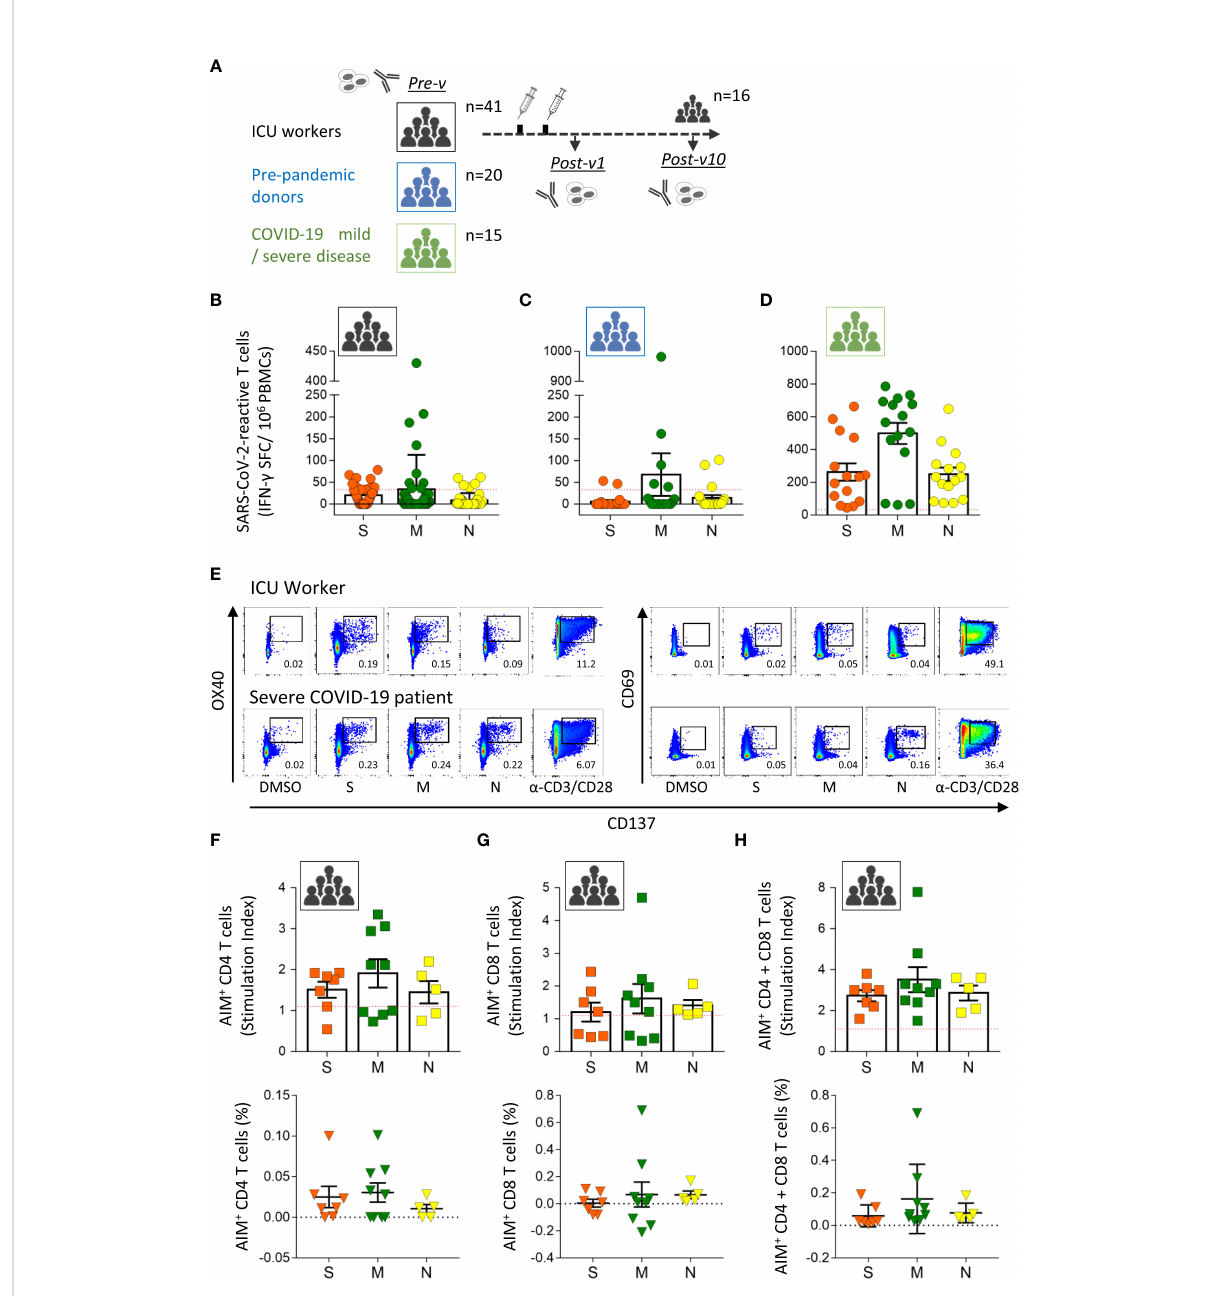
FIGURE 1 Pre-existing SARS-CoV-2-speci fi c T cells in healthy ICU workers. (A) Study design. Blood samples were taken from intensive care unit workers with no known antecedents of COVID-19 before vaccination (n=41, Pre-v), and 1 month (n=41, Post-v1) and 10 months (n=16, Post-v10) after receiving two doses of the mRNA vaccine. Pre-pandemic healthy donors (n=20) and COVID-19 convalescent patients (n=15) with mild and severe disease were used as control groups. Antibody levels and SARS-CoV-2-reactive T cells were assayed at the indicated times. Frequencies of IFN- g -producing T cells assayed by ELISpot assay against spike (S, orange circles), membrane (M, green circles) and nucleocapsid (N, yellow circles) proteins in samples from ICU workers (B) taken before vaccination, pre-pandemic healthy donors (C) and convalescent patients recovered from COVID-19 (D) . Data from ELISpot assays are depicted as the number of spot-forming cells (SFCs) per 1 x 10 6 PBMCs. The red dashed line shows the established cut-off ( ≥ 33.3 SFCs/10 6 cells) after subtraction of negative control values. (E) Flow cytometry dot plots from one ICU workers showing the representative gating strategy to identify antigen speci fi c CD4 + (CD3 - CD4 + OX40 + CD137 + ) and CD8 + (CD3 - CD8 + CD69 + CD137 + ) T cells by AIM assay. A patient with severe COVID-19 was reference as positive control. DMSO and polyclonal induction with anti-CD3/CD28 antibodies were used as negative and positive controls of stimulation for each sample. Numbers in dot plots represent the percentage of AIM + cells in each indicated square. Number of CD4+ (F) , CD8 + (G) T cells or both (H) detected by AIM assay against spike (S, orange squares, n=7), membrane (M, green squares, n=9) and nucleocapsid (N, yellow squares, n=5) proteins in samples from ICU workers that were positive by ELISpot assay. Data from AIM assay are represented as stimulation index (SI, squares) and frequency (triangles). Red dashed line represents the limit of positivity for SI > 1.1. All data are represented as mean ±